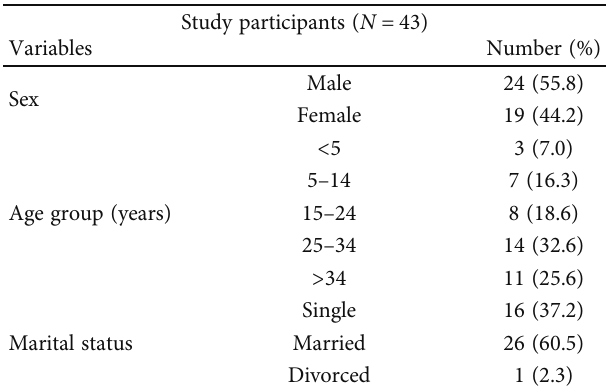
Table 2: Socio-demographic characteristics of the study participants, Boset and Badewacho districts, Southern